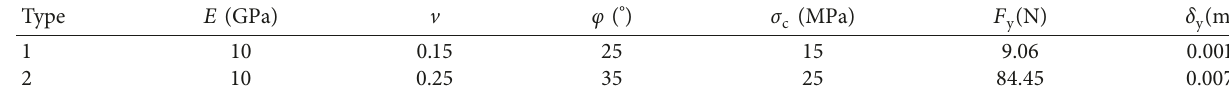
Table 3: Parameters used for interpolation.